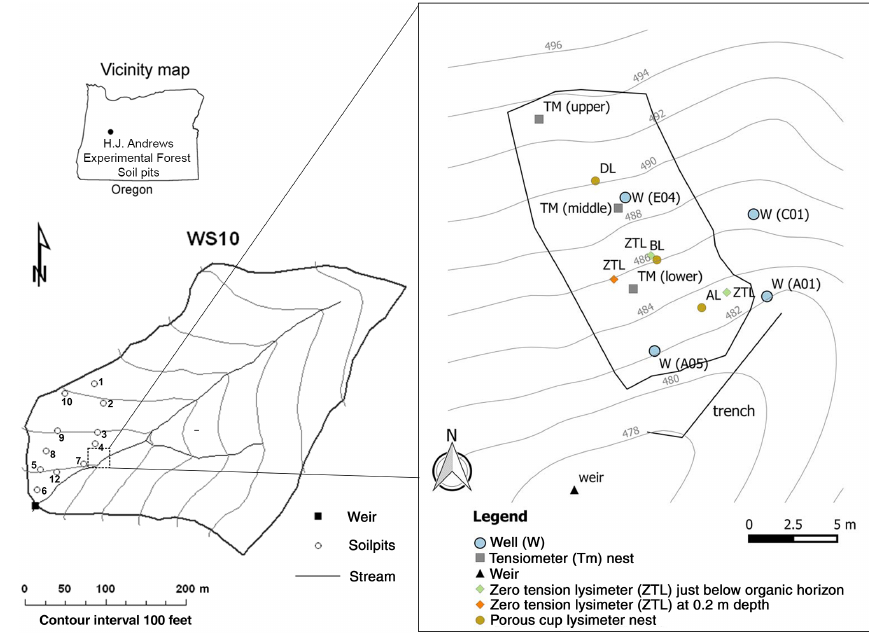
Figure 1. Map of WS10 with soil pits and sprinkler area with instrumentation (see Sect. 3.1 for abbreviation